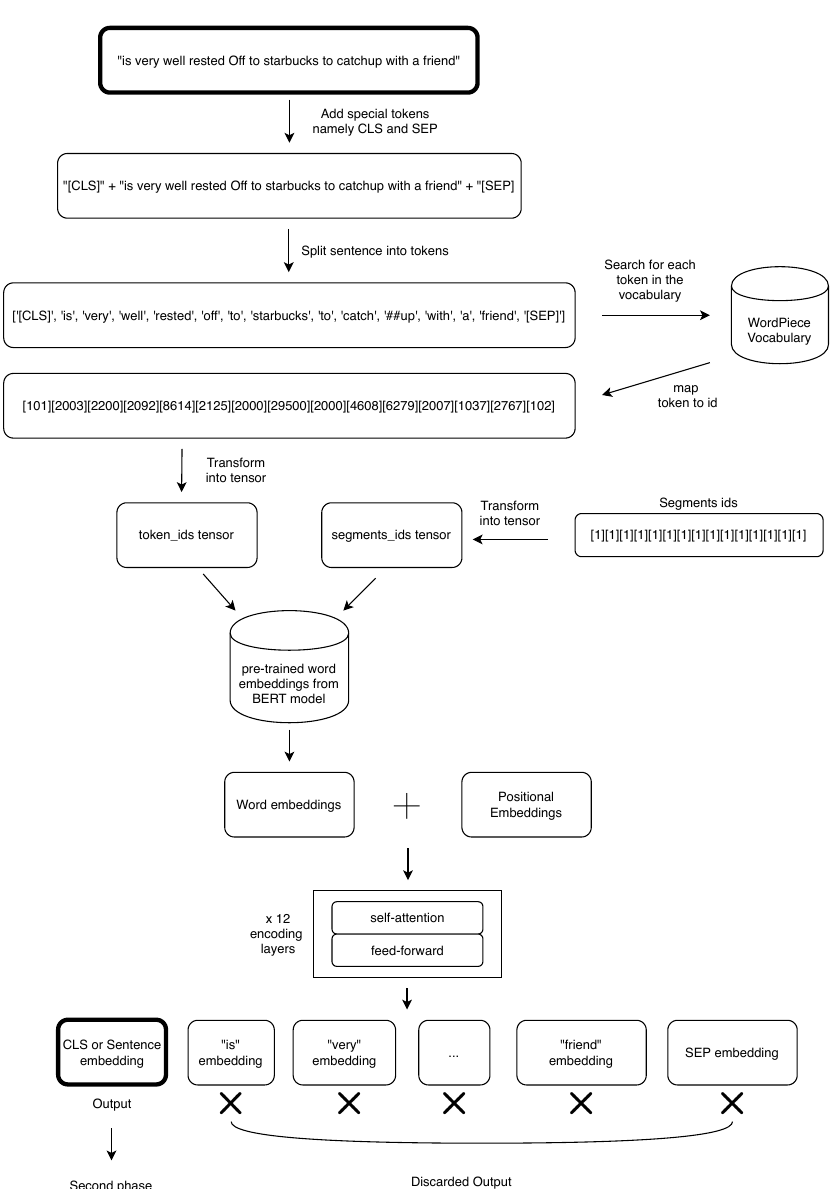
Figure 4. Tokenization and encoding with transformer. Each sentence in myPersonality dataset is processed as shown in figure. After punctuation removal, we add CLS token (classification task special token pre-trained in BERT model as a custom token) at the beginning of the sentence and the SEP token (separation between sentences, pre-trained in BERT model as a custom token) at the end of the sentence. We then split the sentence into tokens. The model is able to consider also out of vocabulary words by splitting them into sub-tokens. The second part of the split words is preceded by ## to tag it as a not standalone word. Tokens are mapped into id contained in the WordPiece vocabulary and the array so-computed is transformed into a tensor. We also need a tensor with the same length of token_ids tensor, called segments_ids tensor made of 1s. The segments_ids is useful to divide tokens belonging to the first sentence (0s) to the second one (1s) when we perform a task that needs two sentences, for example question answering or next sentence prediction. In our case, we need just a sentence, so we load segments_ids with 1s. We load pretrained embeddings from BERT model to output word embeddings from our tensors and we add to them to an initially random positional embeddings. At the bottom of the figure, there are twelve encoding layers having a self attention and a feed forward network inside that encode the input into the final sentence